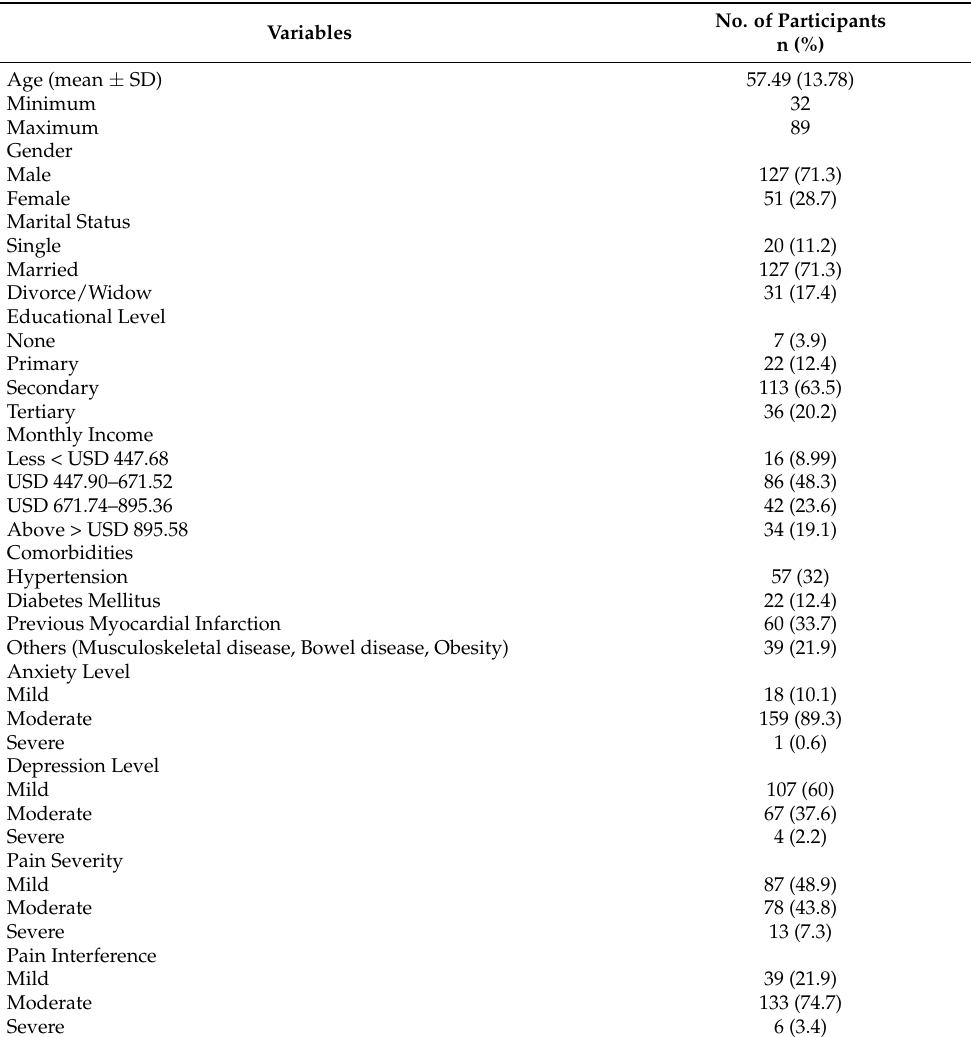
Table 1. Demographic characteristics with the level of anxiety, depression, and pain of the participants (N =